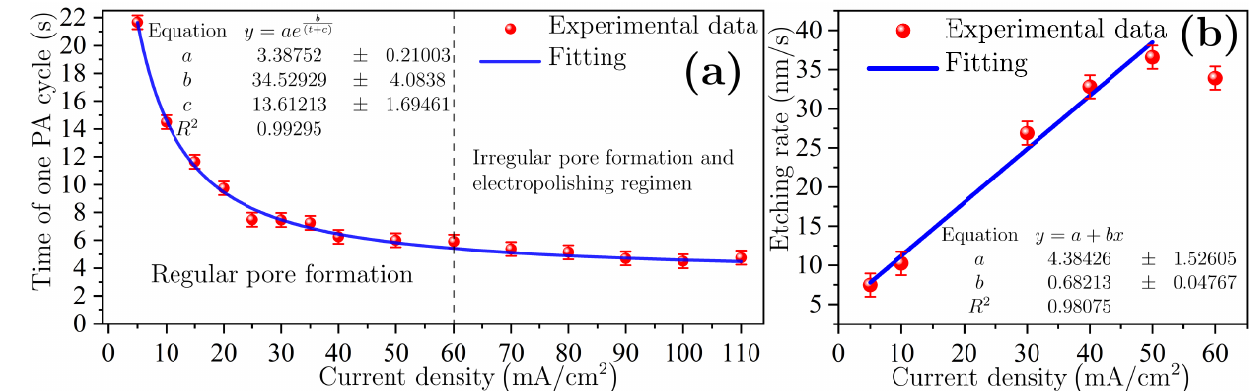
Figure 5. ( a ) Time of one PA cycle as a function of current density. ( b ) Etching rate in the linear regimen ( J < 60 mA/cm 2 ).